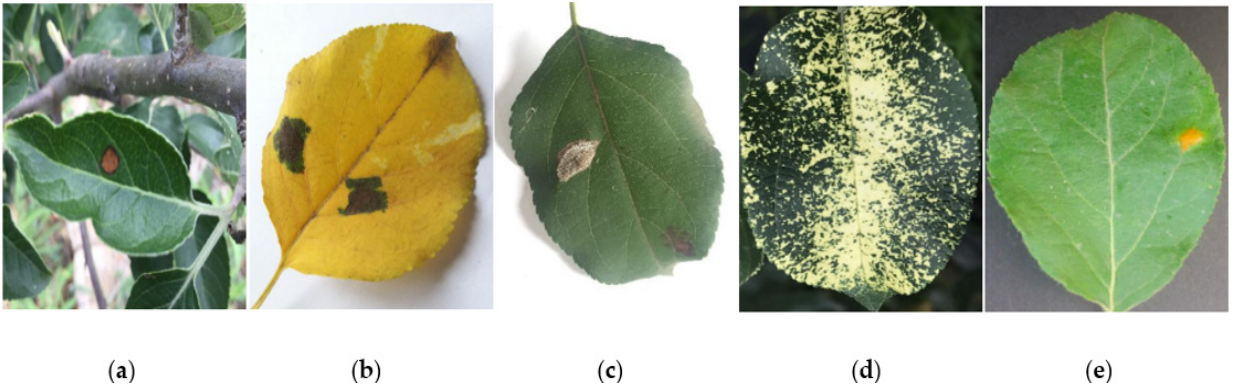
Figure 2. Five kinds of apple leaf diseases. ( a ) alternaria blotch, ( b ) brown spot, ( c ) gray spot, ( d ) mosaic, ( e ) rust.